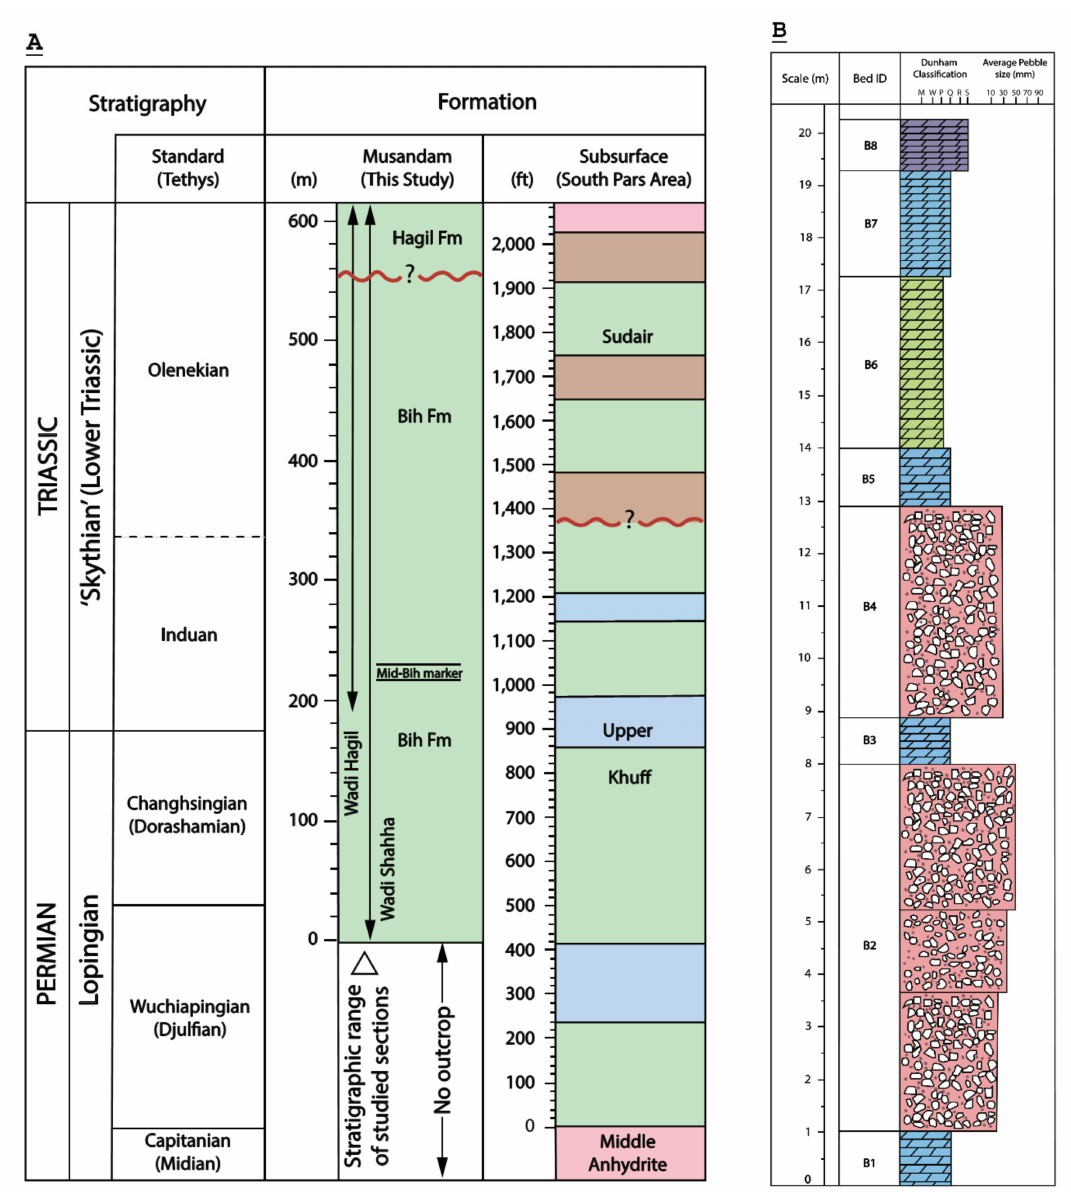
Figure 2. ( A ) Chronostratigraphic framework of the Khuff Formation in the subsurface compared to the stratigraphic range of the Bih Formation [21]. ( B ) Logging graph showing the thickness of conglomerate/breccia beds in the